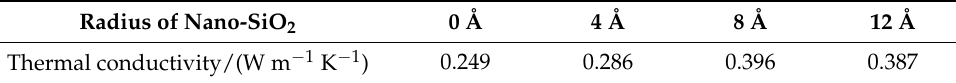
Table 1. Thermal conductivity versus the nano-SiO 2 radius.